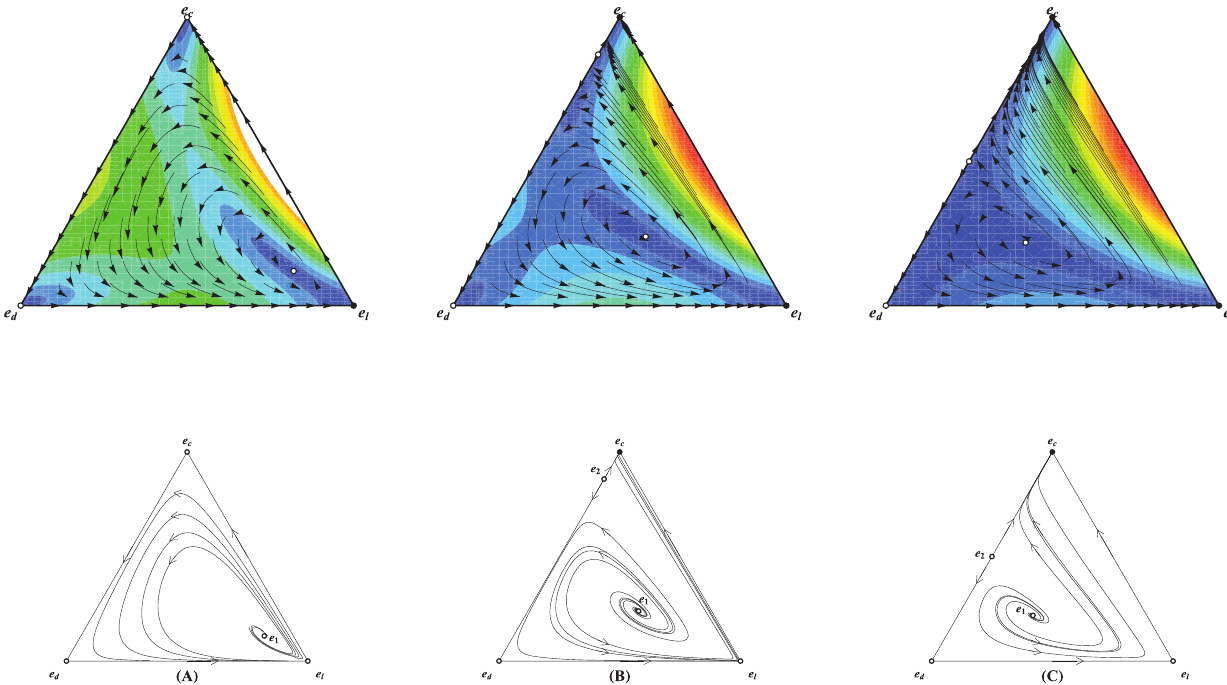
Figure 6. Triangle plots illustrating the population dynamics for defectors ( e d ), cooperators ( e c ) and loners ( e l ) for trajectories starting from all possible initial frequencies for the linear risk removal pattern. Each vertex represents a homogeneous population of that pure strategy. ( A ) For small interest rate r , there is only one nontrivial fixed point ( i : e : , e 1 ) located inside the simplex S 3 . All trajectories starting from inside of the simplex S 3 invariable lead to the unique convergent equilibrium e l . ( B ) For modest r , except e 1 , there also exists another nontrivial fixed point located in the line e c e d ( i : e : , e 2 ). Instead the cooperators’ attraction basin covers absolutely large fraction of the inside area of the simplex S 3 , and loners’ attraction basin is almost negligible. If defectors are abundant, the population dynamics oscillate around the unique unstable interior fixed point e 1 with increasing amplitude and eventually converges to the full cooperative state e c . Otherwise, the population directly drives towards e c . ( C ) Further increase in r continue to expand the cooperators’ attraction basin. It should be noted that even r ~ N , loners’ attraction basin, albeit narrows, does not vanish. Relevant parameters N ~ 10 , m ~ 0 and ( A ) r ~ 3 , ( B ) r ~ 6 , ( C ) r ~ 10